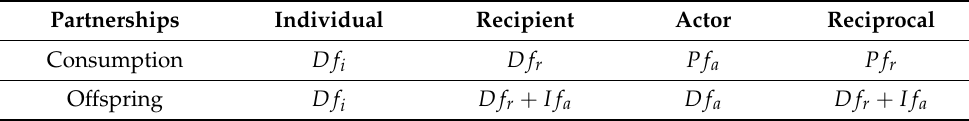
Table 3. Consumption and offspring of